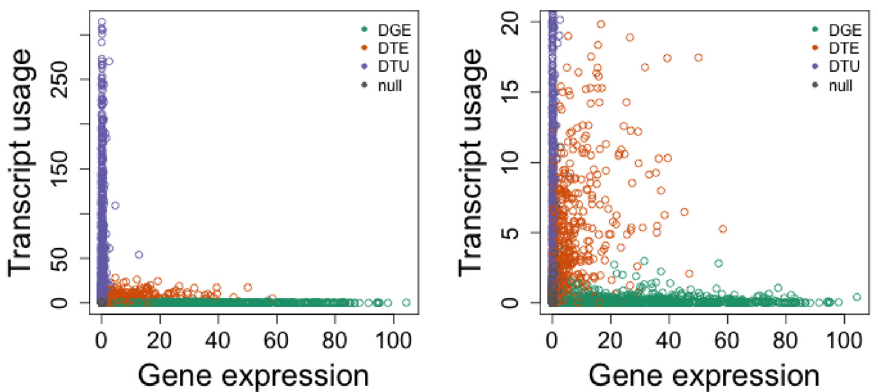
Figure 5. Transcript usage over gene expression plot, as previously, but for DRIMSeq and edgeR. The right panel shows the same data as the left panel but zooming in on the